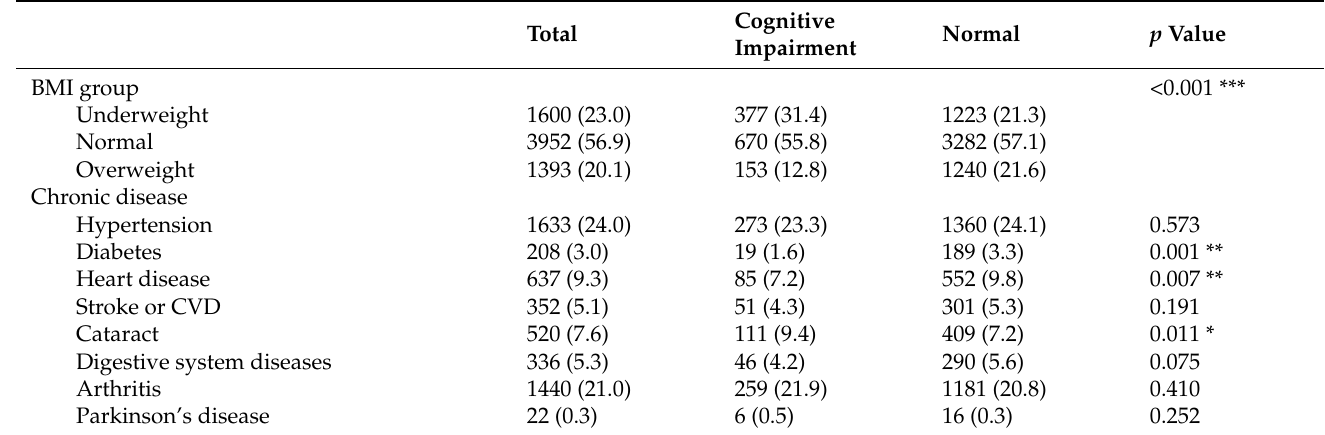
As shown in Figure 2, after multivariable adjustment, the non-linearity association be- tween change in overall protein intake and cognitive impairment was insignificant ( p = 0.122). As shown in Table 2, after multivariable adjustment, the HR of cognitive impairment was 0.98 (95% CI = 0.97–0.99, p = 0.001). The associations between change patterns of protein intake and cognitive impairment have been shown in Supplementary Figure S1.